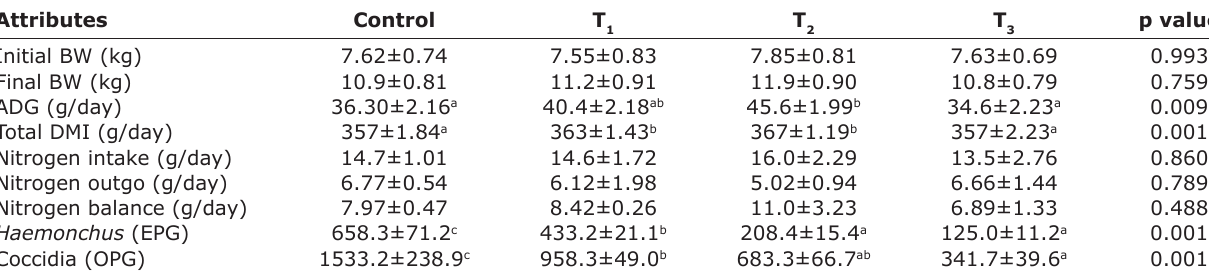
Table-4: Effect of feeding A. nilotica pod meal on fecal egg count and nutrient utilization of goats.